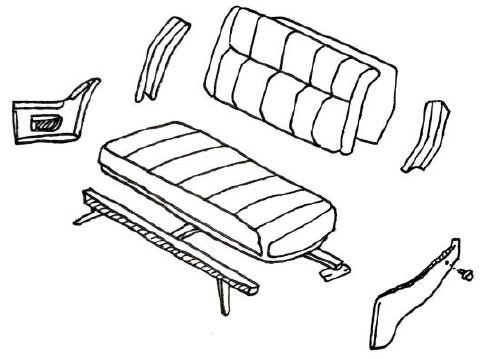
Figure 11. Simple structure [14].